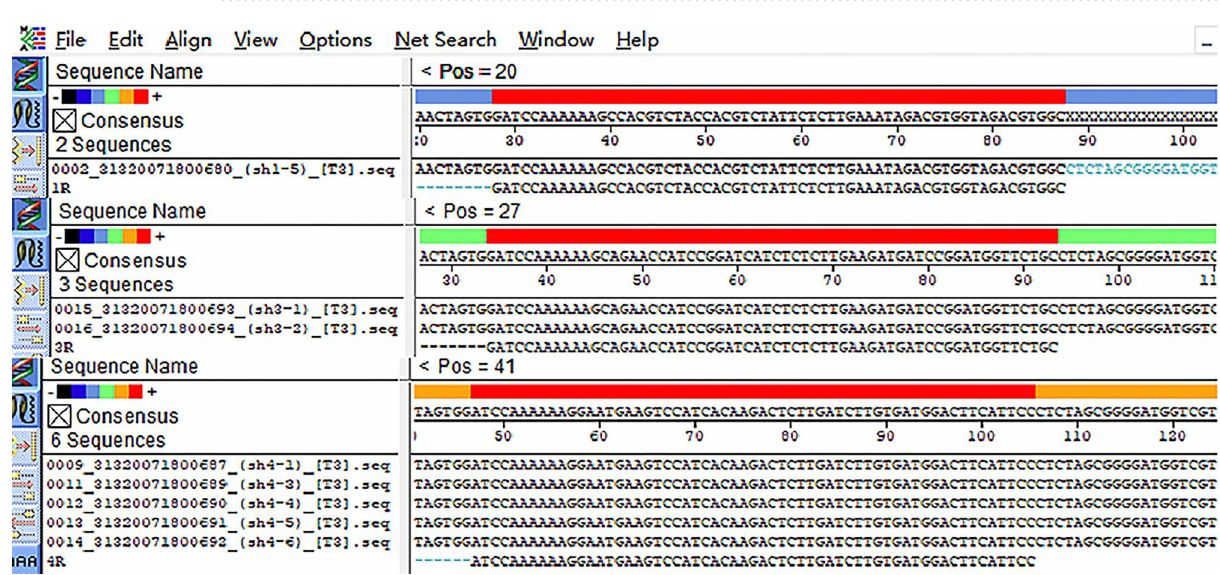
Figure 6. Western blot analysis of the protein expression of the DTX4 gene in bMECs transfected with miR-485 mimics, miR-485 inhibitors, or miR-shNC (* P < 0.05).